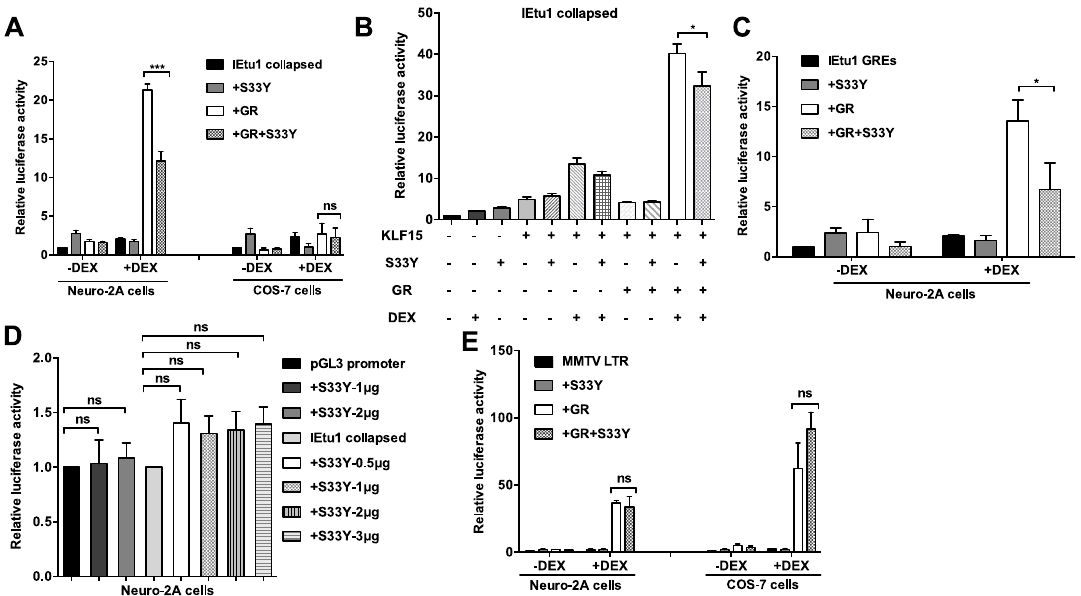
Figure 4. S33Y expression reduced GR-mediated transactivation of the IEtu1 promoter. Panel ( A – C ): Neuro-2A cells or COS-7 cells were cotransfected with the IEtu1 collapsed promoter construct containing the firefly luciferase reporter gene (0.5 μ g) and where indicated plasmids that express GR (1.0 μ g) or S33Y (1.0 μ g). Where denoted, KLF15 (0.5 μ g) and/or S33Y (1.0 μ g). Panel ( D ): The empty pGL3-Promoter vector (0.5 μ g) or IEtu1 promoter (0.5 μ g) was cotransfected with a plasmid expressing the denoted concentration of S33Y. Panel ( E ): Neuro-2A or COS-7 cells were transfected with the MMTV-LTR promoter construct (0.5 μ g), which is a plasmid that expresses GR (1.0 μ g) and/or S33Y plasmid (1.0 μ g). A plasmid that expresses Renilla luciferase (0.05 μ g) was included in all transfections. To maintain the same amount of DNA in each sample, an empty vector was included in certain samples. Cells were incubated with 2% stripped FBS 24 h after transfection and, where indicated, cultures treated with DEX (10 μ M). Dual-luciferase assay was performed as described in the Materials and Methods. The results are the average of three independent experiments, and error bars denote standard error. Student’s T -test was used for statistical analysis: not significant (ns); *, p < 0.05; ***, p < 0.001.